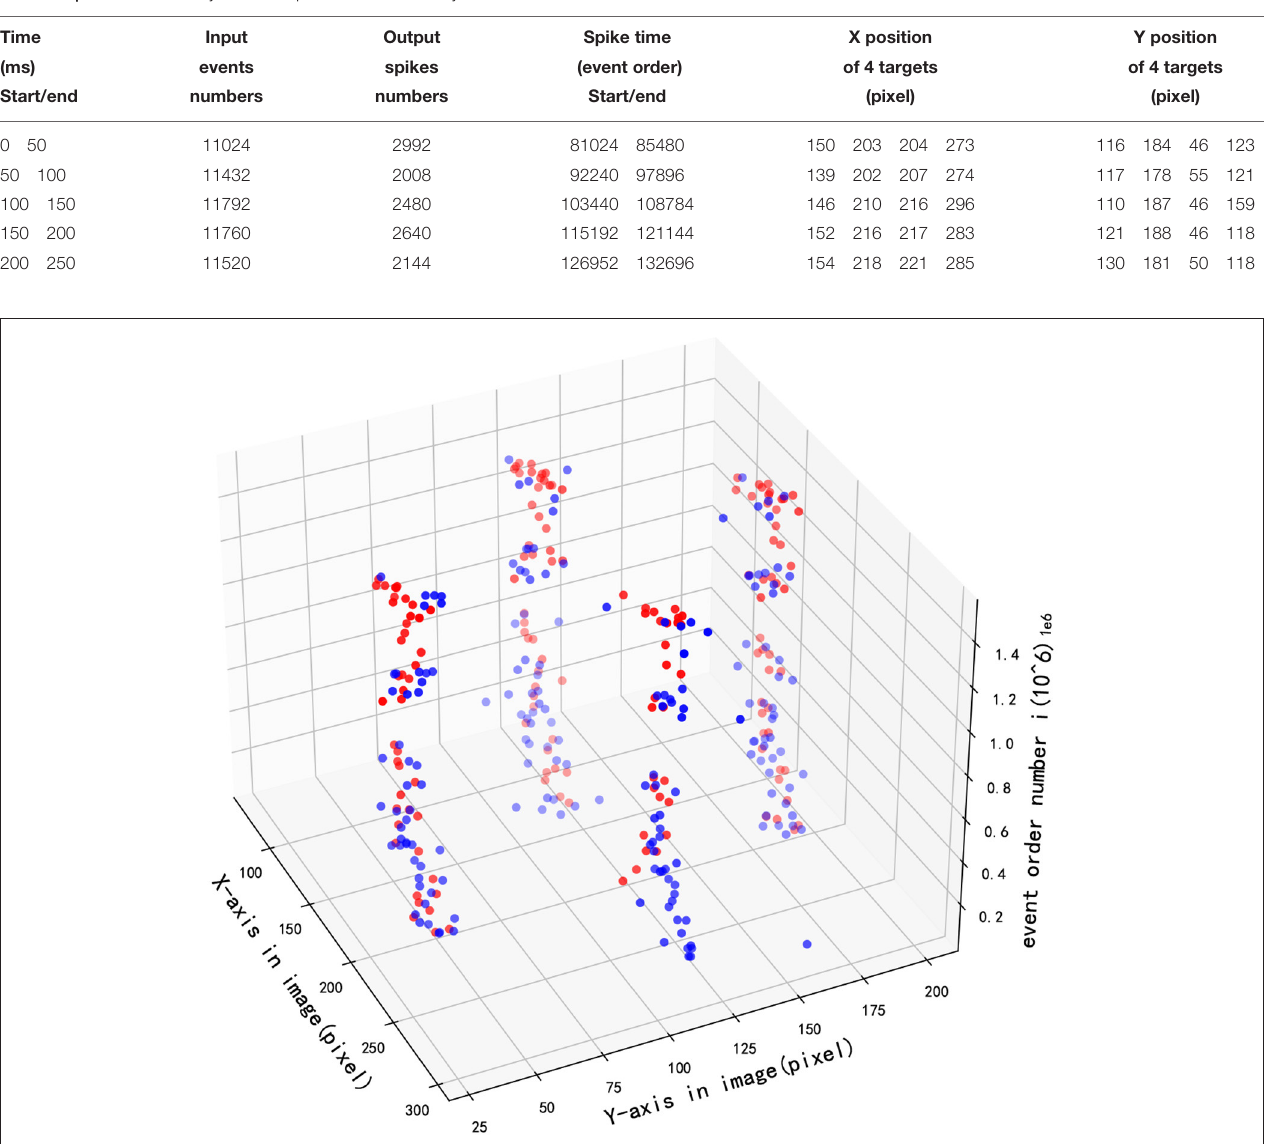
TABLE 3 | Quantitative analysis of multiple circle detection by SNN.